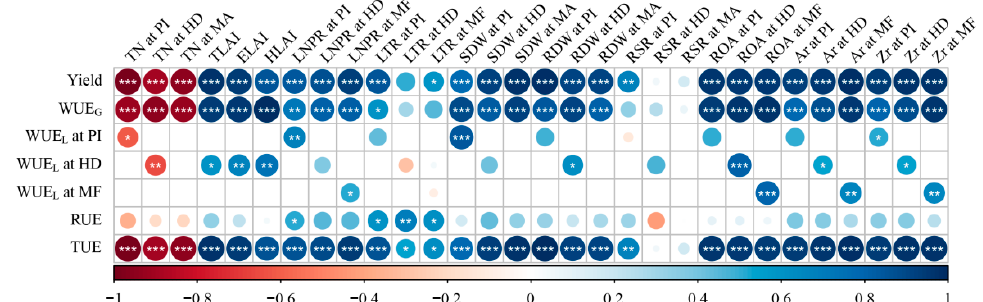
Figure 7. Pearson correlations of agronomic and physiological traits with grain yield and resource use efficiency of mid-season indica rice genotypes. WUE G , grain yield-level water use efficiency; WUE L , leaf-level water use efficiency; RUE, radiation use efficiency; TUE, temperature use efficiency; TN, tiller number; TLAI, total leaf area index; ELAI, effective leaf area index; HLAI, high effective leaf area index; LNPR, leaf net photosynthesis rate; LTR, leaf transpiration rate; SDW, shoot dry weight; RDW, root dry weight; RSR, root–shoot ratio; ROA, root oxidation activity; Ar, abscisic acid levels in root bleeding; Zr, zeatin + zeatin riboside levels in root bleeding; PI, panicle initiation; HD, heading; MF, middle grain filling stage; MA, maturity. Red and blue circles indicate negative and positive correlations between parameters, respectively. The darker the color, the higher the correlation. *, **, *** indicate significant differences at p ≤ 0.05, p ≤ 0.01, and p ≤ 0.001,